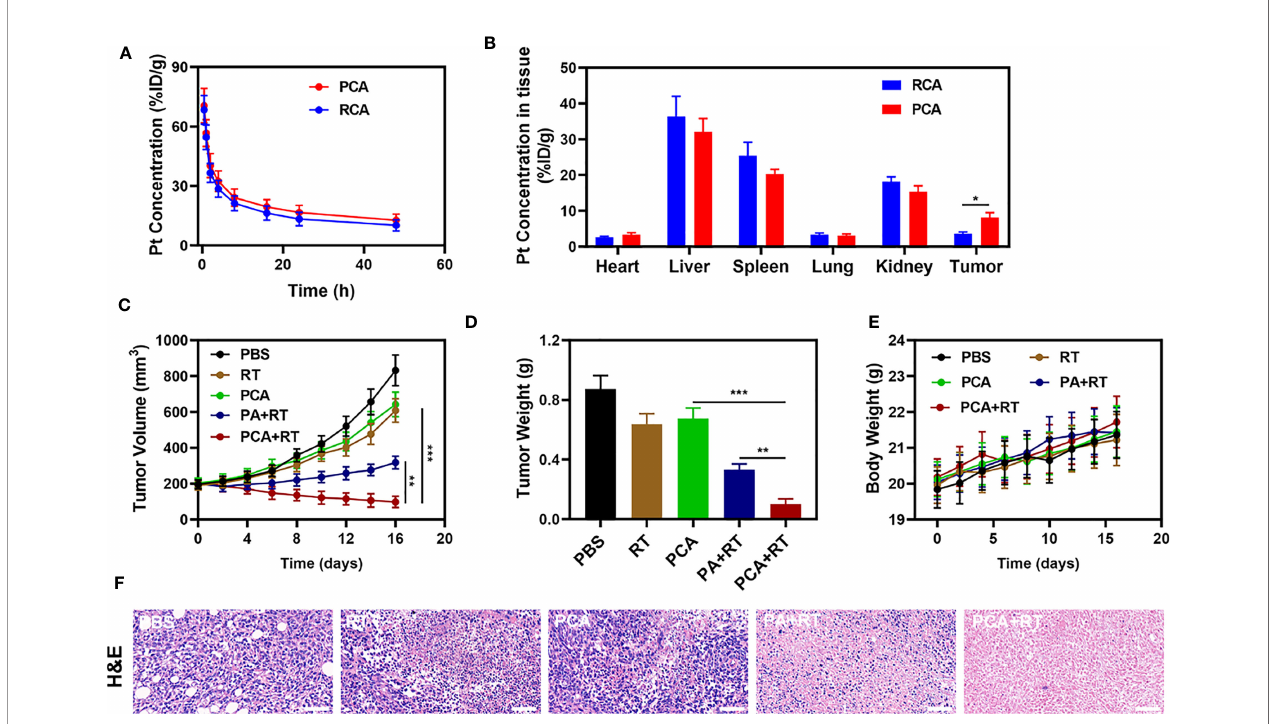
FIGURE 3 | (A) Pharmacokinetic behavior of RCA and PCA in mice following i.v. administration. Data are presented as mean ± SD (n = 3). (B) Quantitative analysis of Pt biodistribution in tissues and tumors of tumor-bearing mice injected with RCA or PCA at CDDP dose of 5 mg/kg, respectively (n = 3). (C) Change in tumor- volume curves of 4T1 tumor-bearing mice after treatments (n = 5). (D) Changes in tumor weight following treatment (n = 5). (E) Body weight of 4T1 tumor-bearing mice as recorded every 2 days following treatment (n = 5). (F) Representative hematoxylin-eosin staining (H&E) stained tumor slice images of mice following treatment (n = 5), scale bars = 100 m m. Signi fi cant differences among groups as calculated using the student ’ s t-test. *P < 0.05, **P < 0.01, ***P <